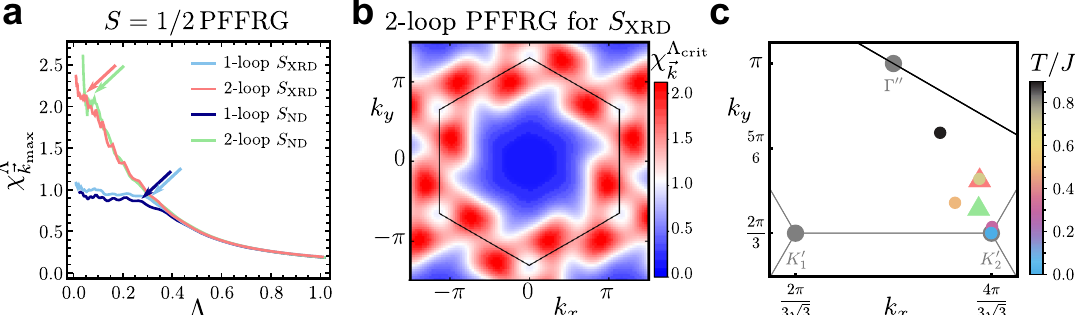
Fig. 8 Pseudofermion functional renormalization group results. a One- and two-loop spin susceptibility fl ows from PFFRG for S XRD and S ND structures. The arrows mark a kink or peak during the fl ow indicating the onset of magnetic order. b Spin susceptibility in two-loop S = 1/2 PFFRG for S XRD structure at the critical cutoff (marked by the red arrow in ( a )). The extended Brillouin zone is indicated by the Λ crit black hexagon. Maxima of χ ~ k appear at incommensurate positions. c Momentum-space position of the maximal susceptibility at the breakdown of the PFFRG fl ow together with the corresponding values obtained from classical Monte Carlo at fi nite temperature T . We show a section of the fi rst Brillouin zone (gray lines) close to one edge of the extended Brillouin zone (black line), confer Fig. 1b. The PFFRG results for the S XRD parameters are shown as triangles (the peak positions for the S ND structure are similar). Red and green triangles represent one-loop and two-loop results, respectively. Dots represent the susceptibility maxima from classical Monte Carlo for the system with S XRD couplings and the color represents